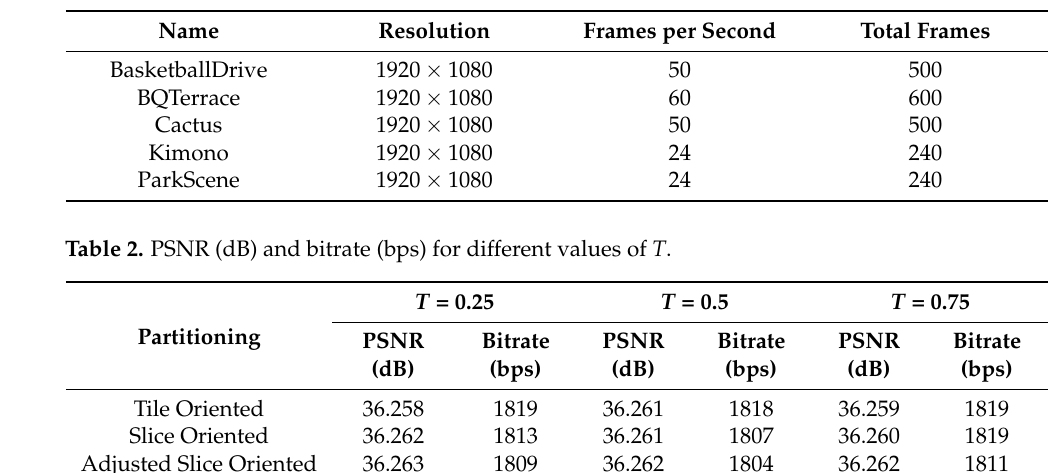
Table 1. CTS video sequences.